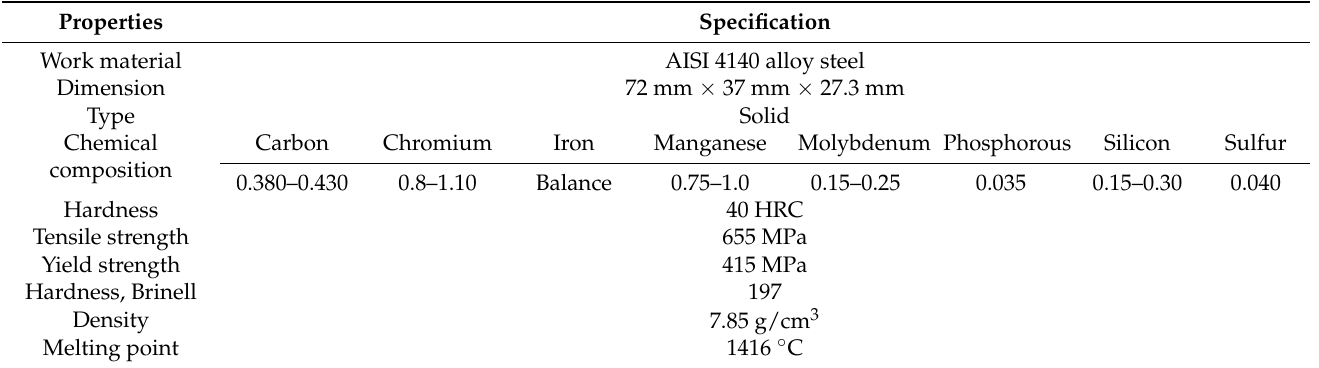
Table 2. Chemical composition and properties of the workpiece material.